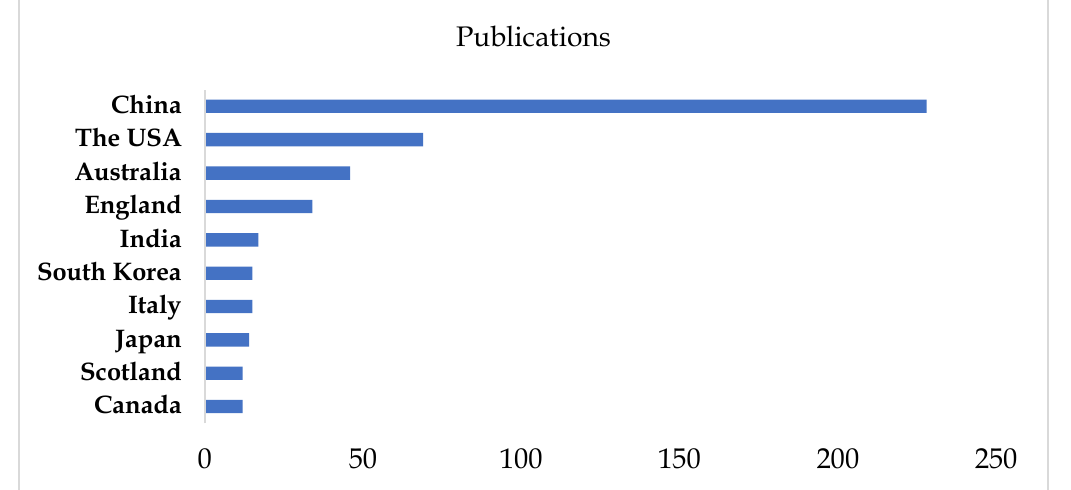
Figure 7. Top ‐ 10 most productive nations on Blockchain in the construction industry. Figure 7. Top-10 most productive nations on Blockchain in the construction industry.